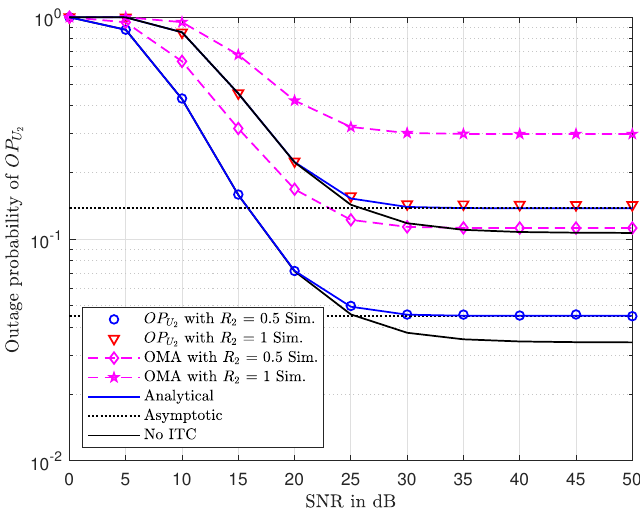
Figure 2. Outage probability of OP U